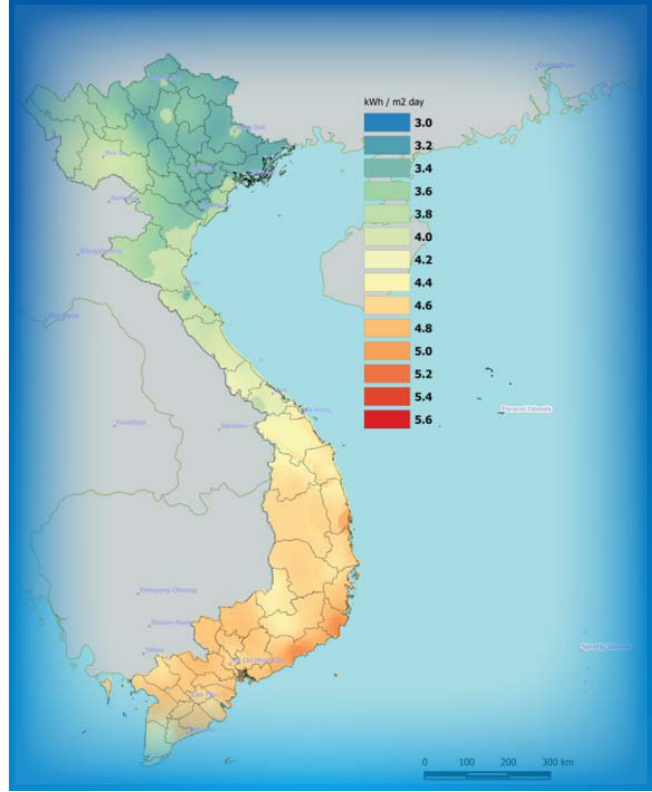
Figure 1. Map of the annual average daily global horizontal irradiation .